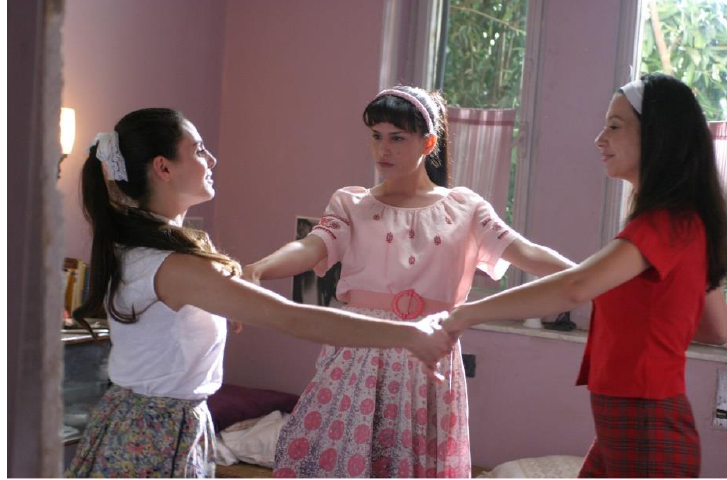
Figure 1. Dina Zvi-Riklis, Three Mothers ( Shalosh Imaot , 2006), Adolescence in Israel. Credit: Yoni Hamenachem. Used with the director’s permission.